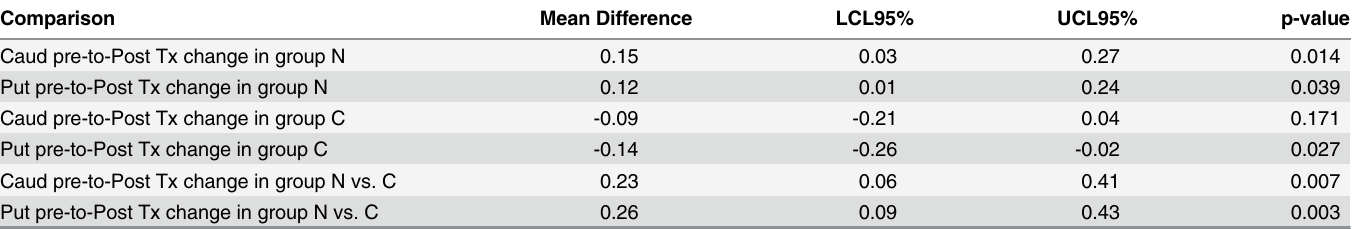
Table 3. Mean pre-to-post-Tx differences in dopamine transporter